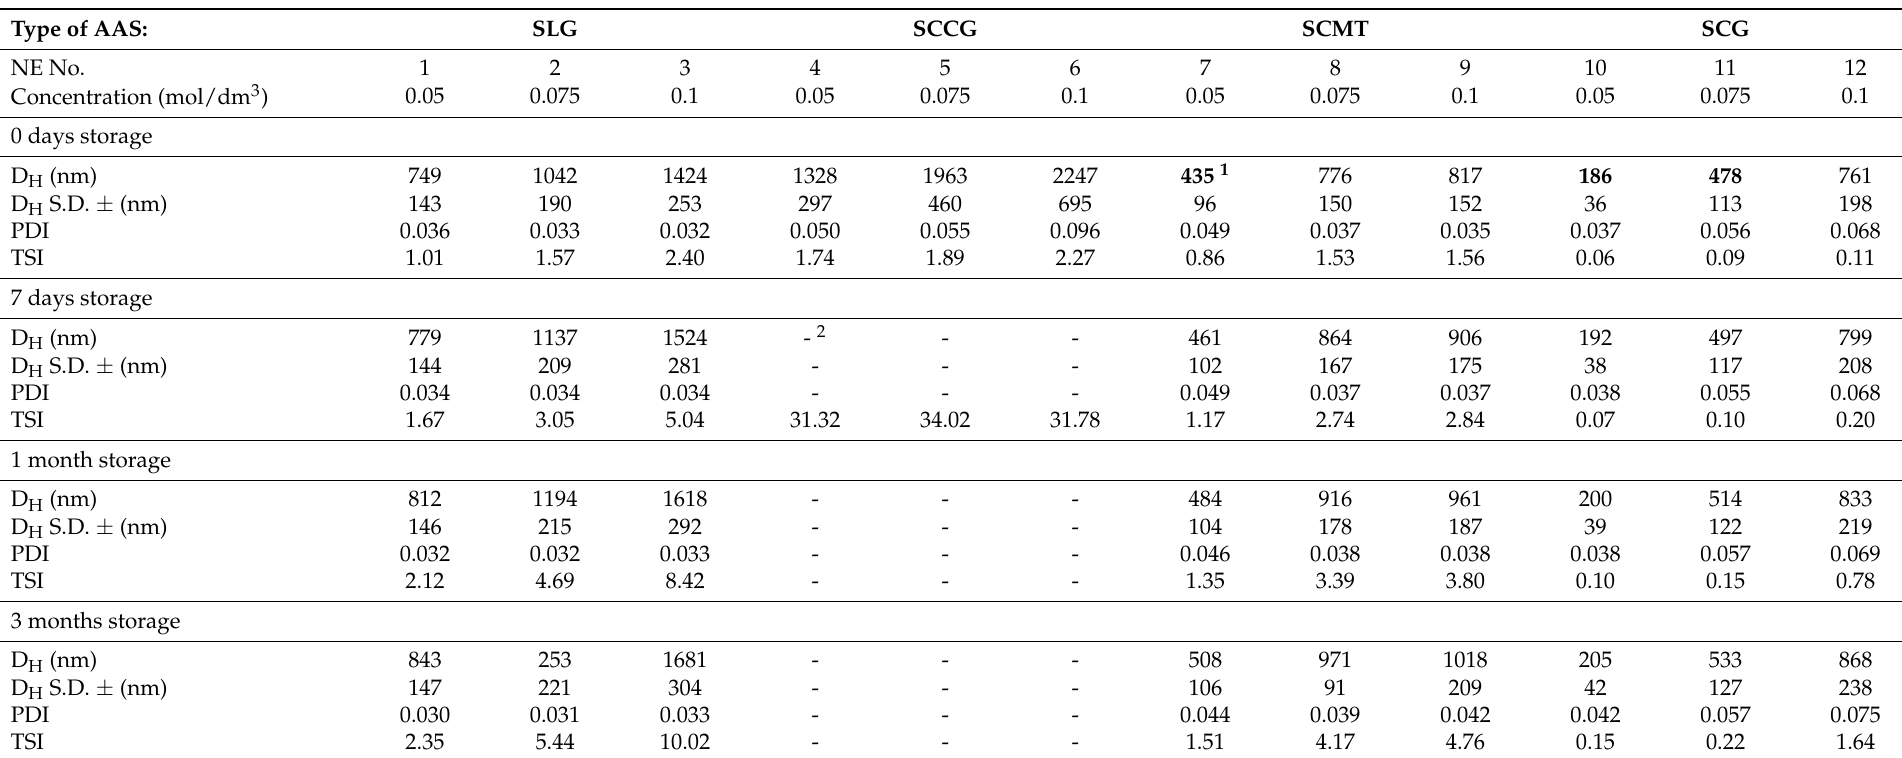
Table 2. Physicochemical characterization of the products after HPH at P = 150 MPa and after five cycles of